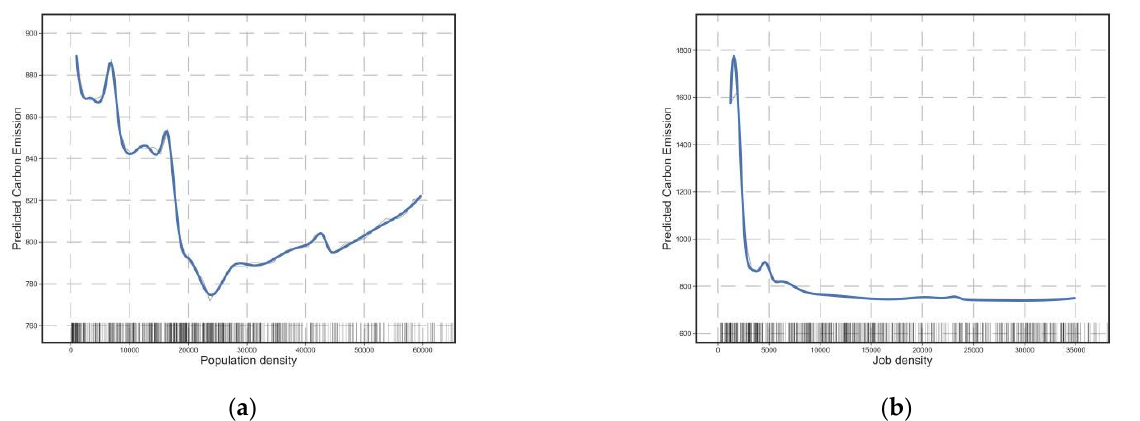
Figure 3. Influence of density on commuting CO 2 . ( a ) The relationship between population density and commuting CO 2 ; ( b ) The relationship between job density and commuting CO 2.